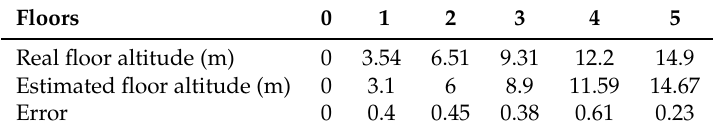
Table 9. Ground truth, estimated altitude and error for